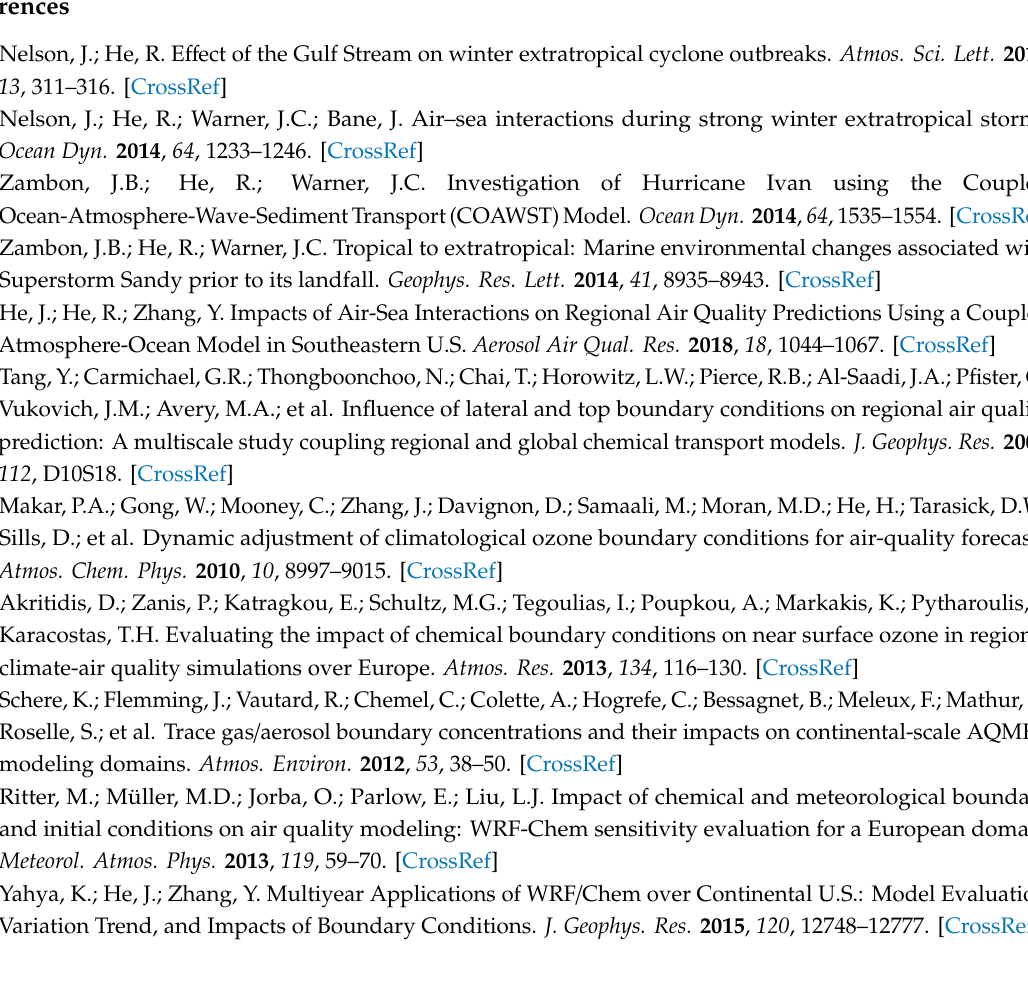
and MUMBA. Two sets of simulation results at 3 km are compared, one from WRF / Chem-NCSU and one from WRF / Chem-ROMS. Figure S5: Di ff erences in simulated gases between WRF / Chem-ROMS and WRF / Chem-NCSU over the Greater Sydney (d04). Figure S6: Observed and simulated column mass abundances of gases and AOD without and with adjustment of boundary conditions over the Greater Sydney (d04) for SPS2. The simulation results are from WRF / Chem-NCSU. Figure S7: Observed and simulated surface concentrations of CO at selected sites during SPS1 (left) and SPS2 (right). Two sets of simulation results from WRF / Chem-NCSU at 3 km are compared, one using CO boundary conditions derived from CESM simulations (Base) and one using CO boundary conditions constrained by satellite data (Final). Table S1: The adjustment factors used for the satellite-constrained BCONs for the AUS